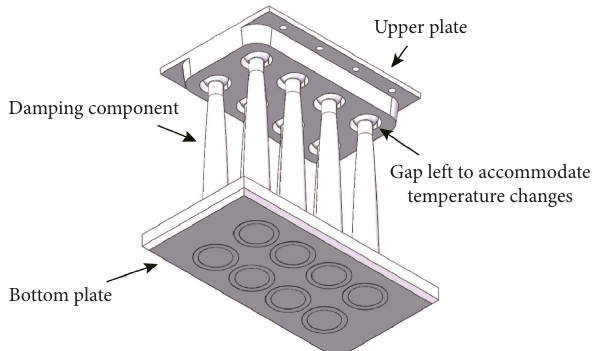
Figure 5: Configuration of the cylindrical damping device.